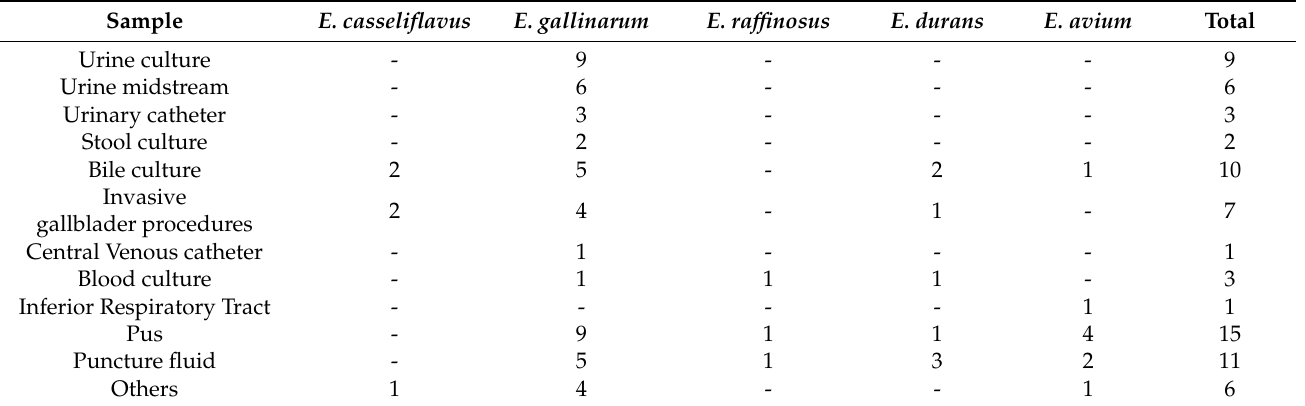
Table 2. Distribution of other Enterococci among different